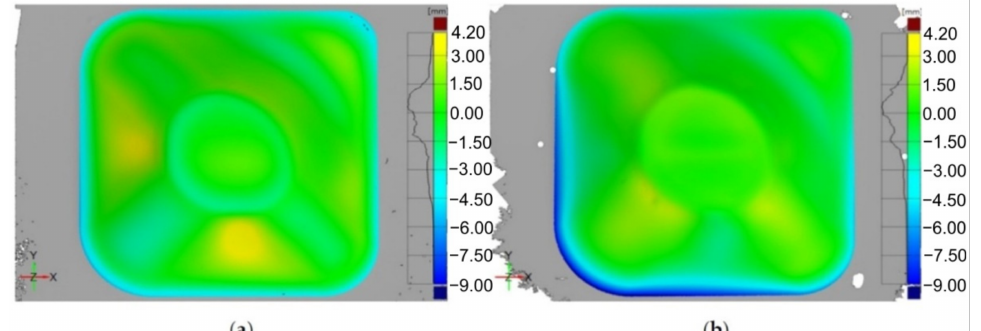
Figure 22. Accuracy analysis for ( a ) an uncompensated trajectory and ( b ) for a trajectory compensated with the intelligent modelling (reproduced with permission from [105]; copyright © 2015, The Authors; this is an open-access article distributed under the terms of the Creative Commons CC BY license, which permits unrestricted use, distribution and reproduction in any medium, provided the original work is properly cited).